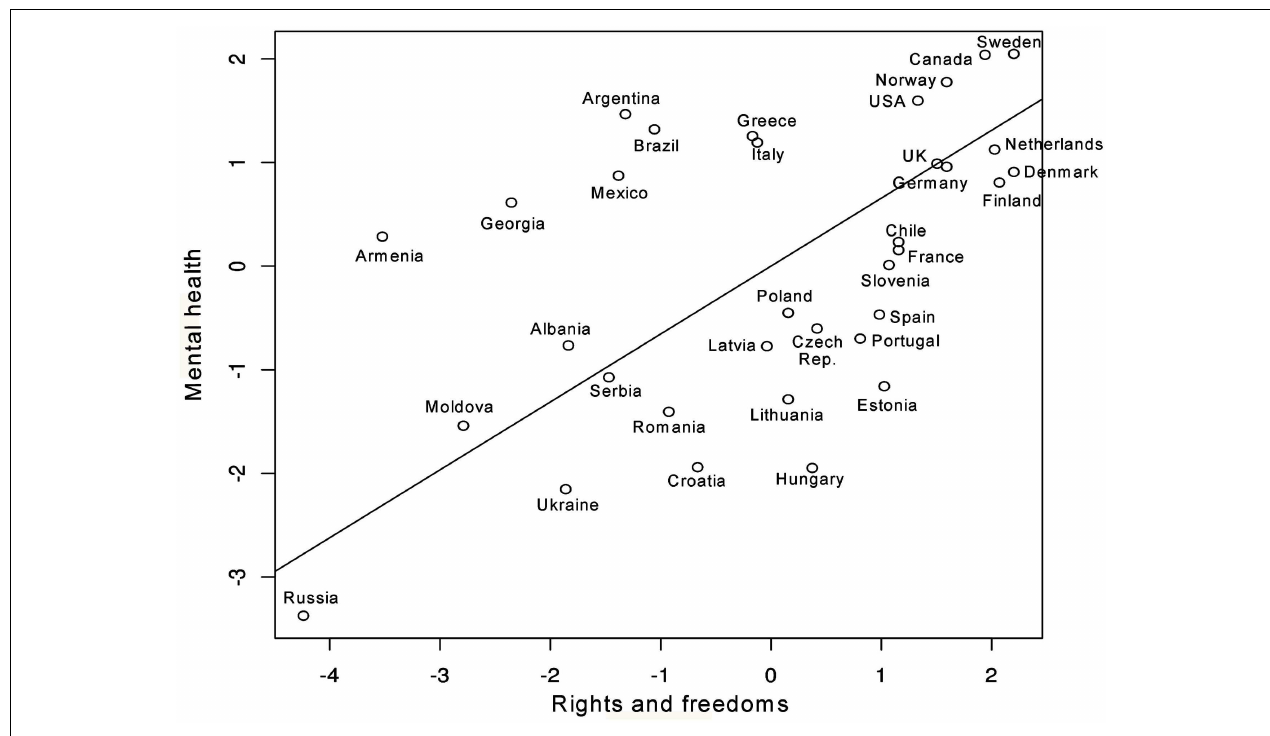
FIGURE 9 | Scatterplot of rights and freedoms versus mental